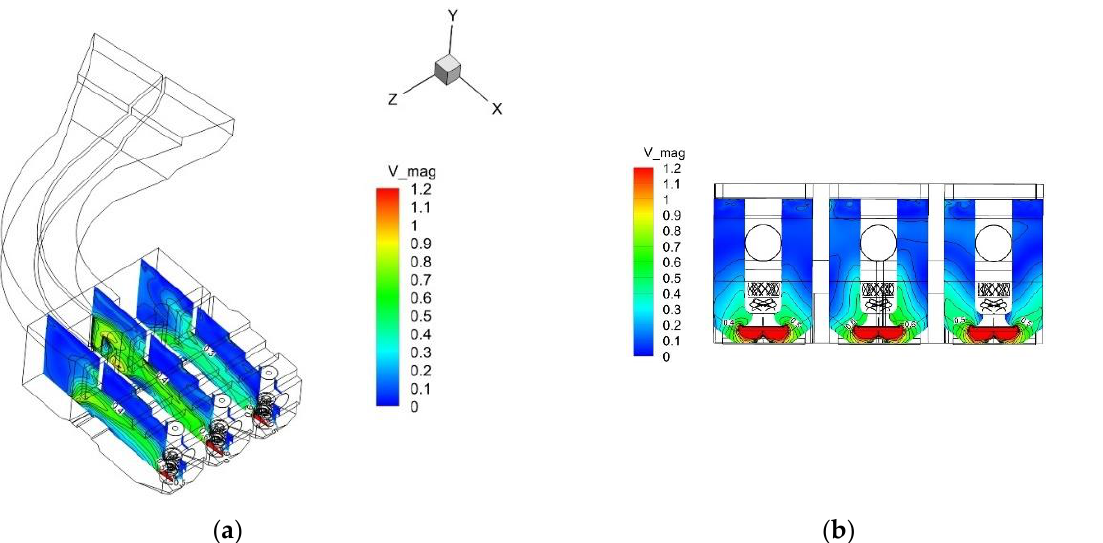
Figure 18. Plan 10 isogram of velocity. ( a ) Center section of pump body along flow direction. ( b ) Center section of pump body in vertical flow direction.